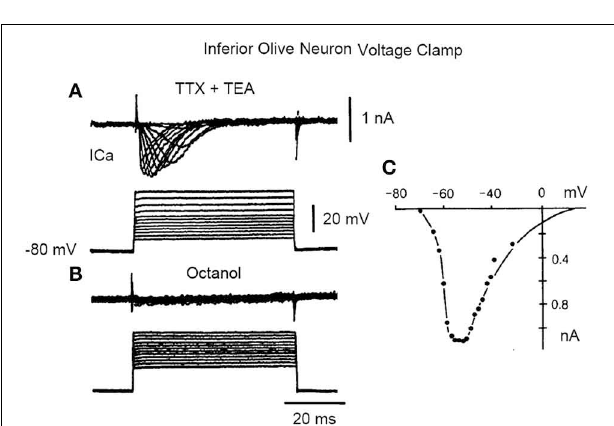
dendritic spike [g Ca(dendtritic) ] that generates the afterdepolarization and the powerful, long-lasting afterhypolarization, which is produced by a Ca 2 + -dependent K+ conductance [g K (Ca) ]. In addition, a voltage-dependent K + conductance (g K ) seems to be present in the dendrites. Right A: Rebound spikes in the inferior olivary neuron (arrow) following blockage of the Na spike with tetrodotoxin (TTX). Right B: Summary of the ionic conductances that generate single-cell oscillations in neurons of the inferior olive.